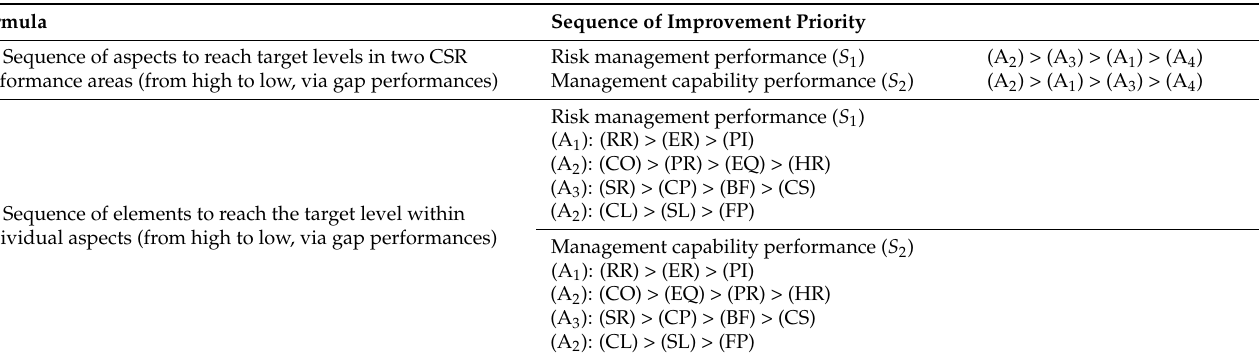
Table 4. Sequence of improvement priorities for CSR